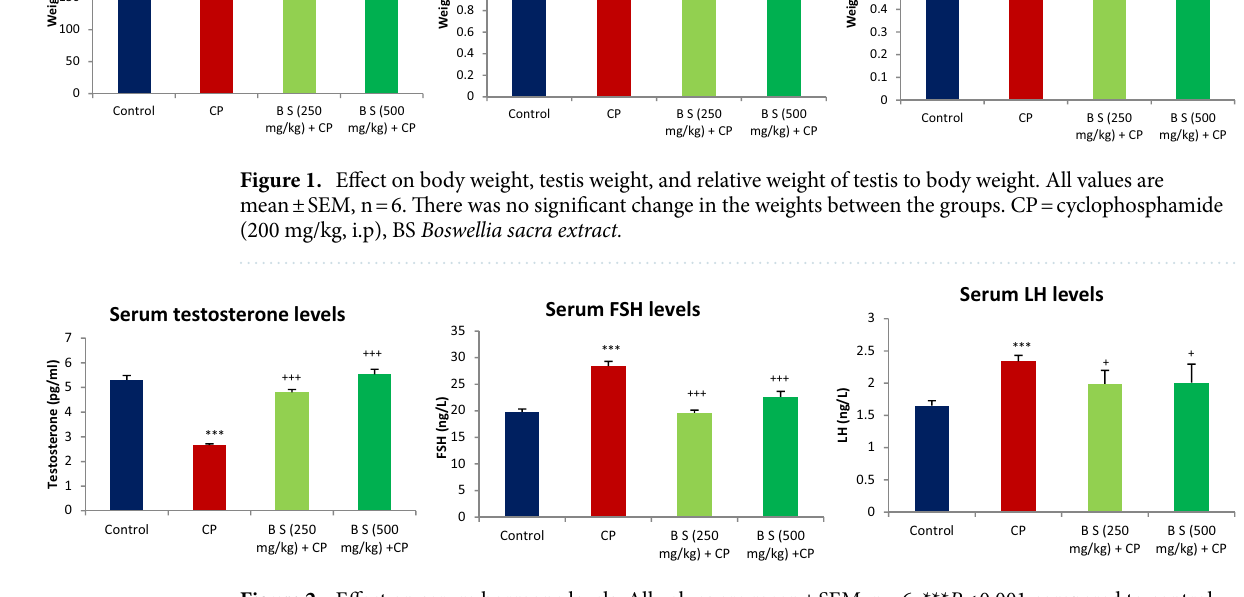
Figure 2. Effect on serum hormone levels. All values are mean ± SEM, n = 6. *** P < 0.001 compared to control. + P < 0.05, +++ P < 0.001 compared to CP treated group CP = cyclophosphamide (200 mg/kg, i.p), B S = Boswellia sacra